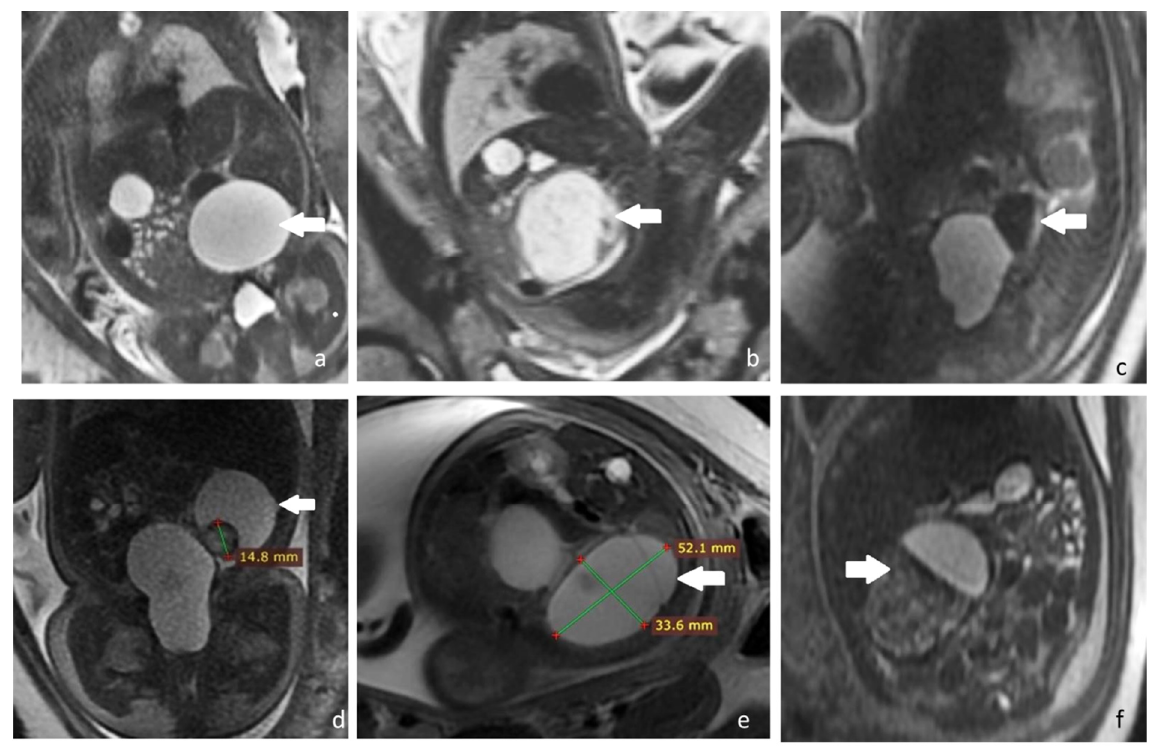
Figure 4. Fetal ovarian cyst-MRI aspects. All images are T2 SSFSE (single shot fast spin echo): ( a ) Simple ovarian cyst. Coronal view with a fluid filled cyst (arrow); ( b ) hemorrhagic cyst. Sagittal view with an inhomogeneous cyst, with hypointense fluid-fluid level (arrow); ( c ) hemorrhagic cyst. Sagittal view showing a cyst with hemorrhagic hypointense content and fluid-fluid level (arow); ( d ) daughter cyst. Coronal view showing a hemorrhagic daughter cyst in a larger fluid filled cyst (arrow); ( e ) septated ovarian cyst. Axial view showing a cyst with fine internal septations and uncomplicated fluid hyperintensity (arrow); ( f ) ovarian torsion. Enlarged ovary with inhomogeneous structure and a fluid-filled cyst, mimicking a fluid-fluid level (arrow).